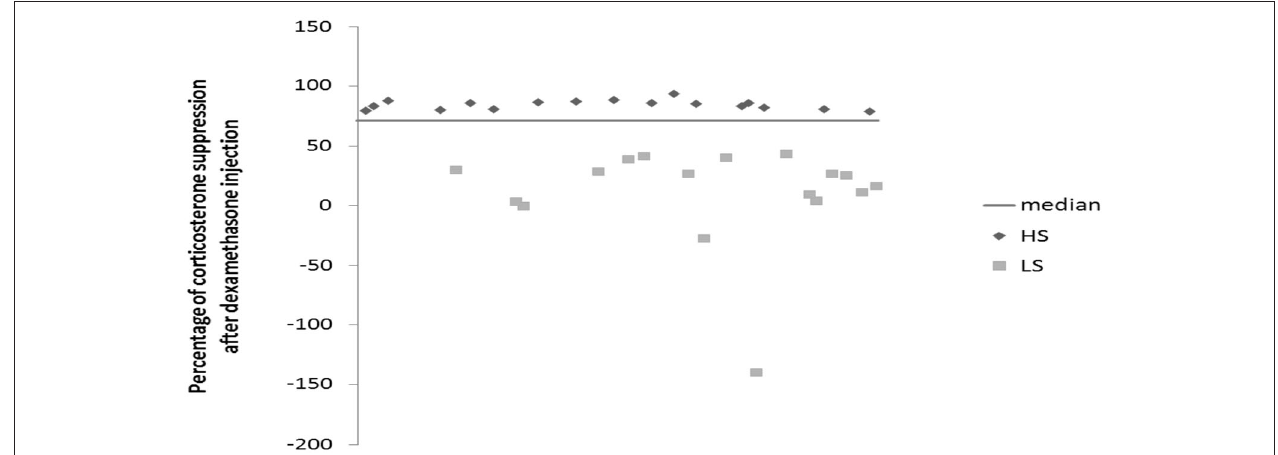
FIGURE 1 | Effects of 2 weeks of unpredictable chronic mild stress (UCMS) on the dexamethasone suppression . Data represent the percentage of corticosterone suppression after dexamethasone injection HS ( N = 17), LS ( N =